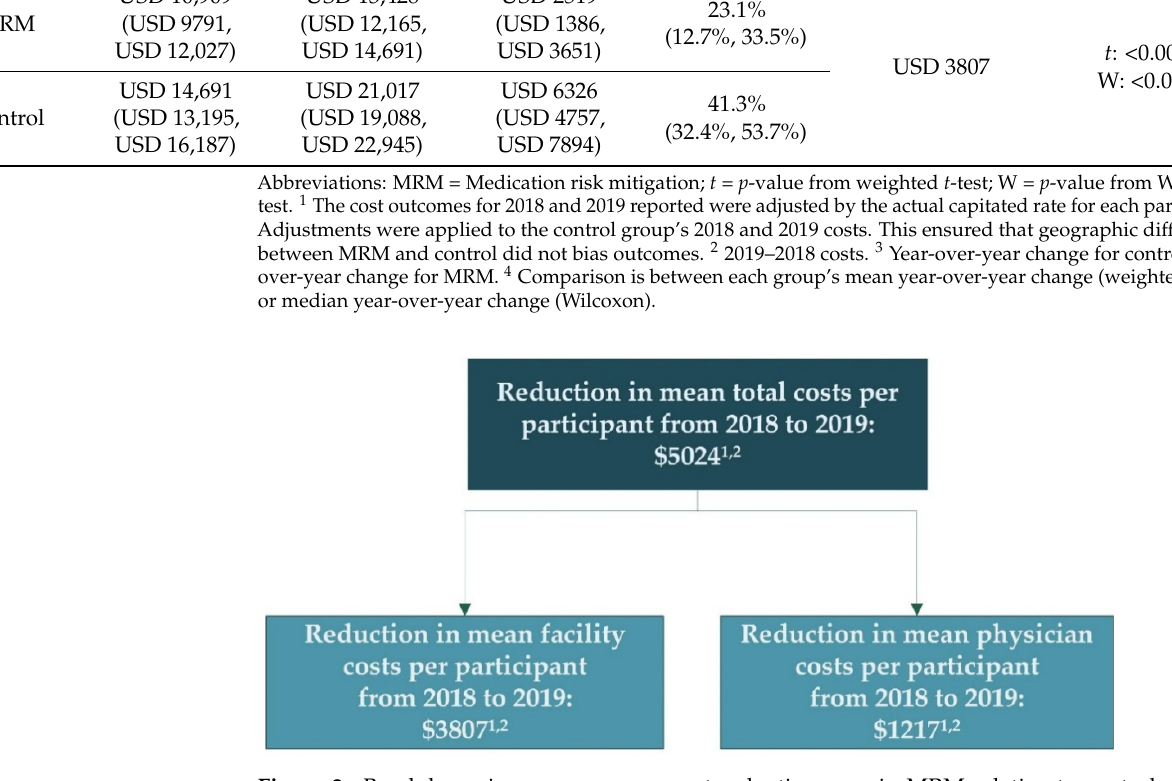
Figure 2. Breakdown in year-over-year cost reduction seen in MRM relative to control. 1 Cost reduction represents the difference between the intervention and control group’s 2018-to-2019 change in medical costs. Adjustments were applied to the control group’s 2018 and 2019 costs. Adjustments were based on the actual capitated rate. This ensured that geographic differences between MRM and control did not bias outcomes. 2 Denotes a statistically significant ( p < 0.05) difference between MRM and control groups.